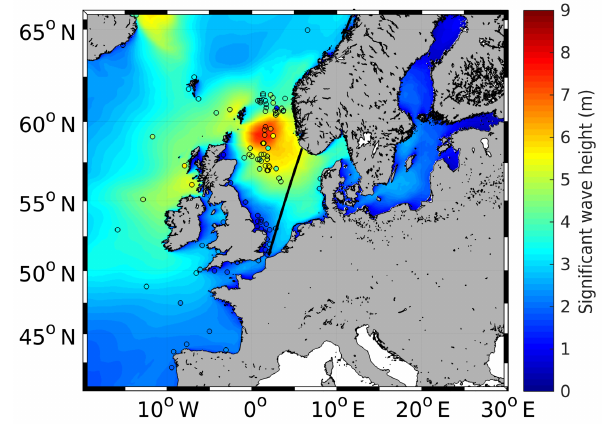
Figure 9. Best guess of the significant wave height of the ensemble (coloured), together with the Sentinel-3A track (line) and the GTS measurements (dots), on 29 September 2016 at